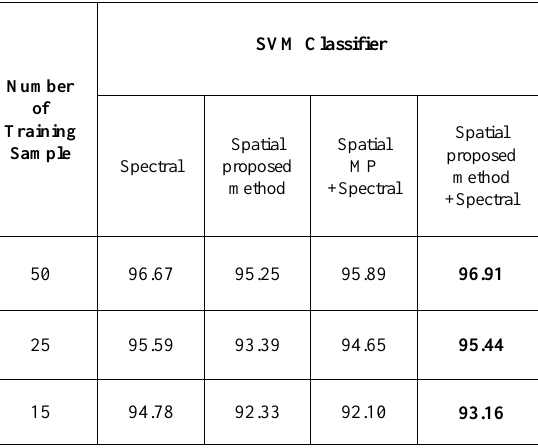
Table 2 : Overall accuracy (OA) on the Pavia Center